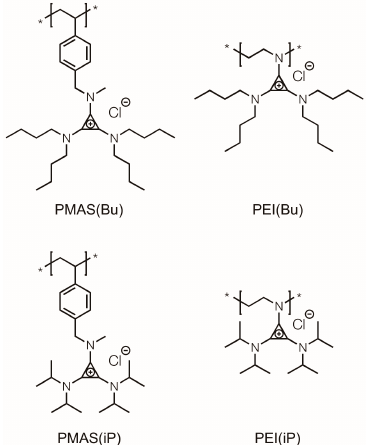
Figure 1. Trisaminocyclopropenium (TAC) polymer structures examined for biocompatibility and transfection efficacy. PEI: polyethylenimine; PMAS: poly(methylaminostyrene); Bu: n -butyl; iP: isopropyl.